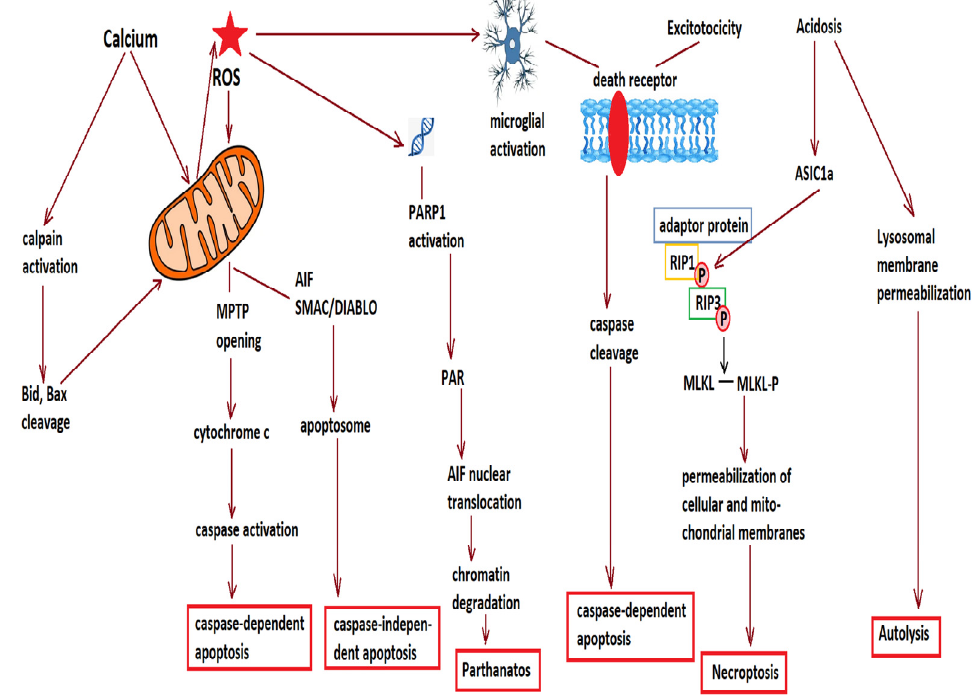
Figure 1. Various mechanisms contribute to cell loss in the penumbral area. Reactive oxygen species (ROS) and increased cytosolic calcium damage mitochondria, and lead to opening of the mitochondrial permeability transition pore (MPTP) and release of cytochrome c and apoptosis inducing factor (AIF). Increased calcium also activates calpains, which cleave pro-apoptotic factors such as Bid and Bax, promoting their mitochondrial translocation and further permeabilization of the mitochondrial membrane. Cytochrome c activates the caspase cascade and leads to caspase-dependent apoptosis, while AIF and second mitochondrion-derived activator of caspase/direct inhibitor of apoptosis-binding protein with low pI (SMAC/DIABLO) activate caspase-independent apoptosis. ROS also damage DNA and activate poly(ADP-ribose) polymerases (PARP), leading